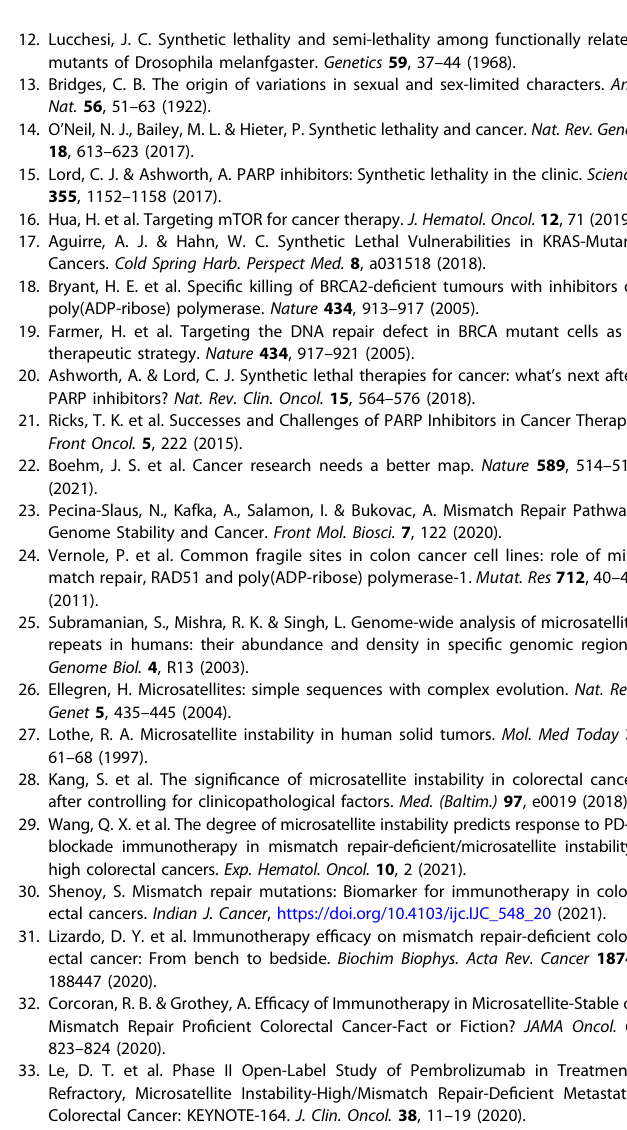
Fig. 2 Roadmap towards the use of WRN inhibitors in the clinic. Future clinical success of WRN inhibitors hinges on three pillars: drug development, tumour pro fi ling, and patient strati fi cation. Development and re fi nement of WRN inhibitors that are potent, selective, bioavailable, and relatively safe is an absolute requirement. Improvements in genetic and epigenetic tumour pro fi ling through deep sequencing, liquid biopsies, and other technologies would provide a clearer picture of intra-tumour heterogeneity. Moreover, MSI testing will need to be coupled with (TA) n repeat expansion pro fi ling to predict the potential of WRN inhibition. Finally, risk analysis through cancer modelling and biomarker identi fi cation will invariably improve patient strati fi cation. Figure was created with